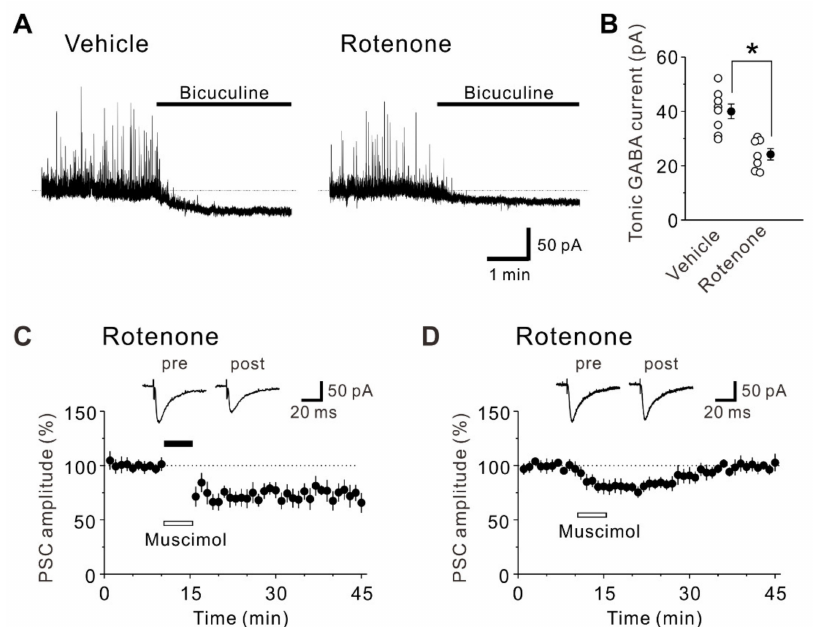
Figure 4. Reduction of tonic GABA currents caused by intranasal administration of rotenone and restoration of LTD by muscimol in pyramidal neurons of rotenone-treated mice. ( A ) Representative current traces recorded before and during application of 10 µ M bicuculline in pyramidal neurons obtained from vehicle-treated mice (left) and rotenone-treated mice (right). ( B ) Summary scatter plots of tonic GABA currents obtained from pyramidal neurons of vehicle-treated mice ( n = 8) and rotenone-treated mice ( n = 7). Unpaired t -test, *: p < 0.001. ( C ) LTD was induced by LTD-inducing stimuli in pyramidal neurons of rotenone-treated mice when 50 µ M muscimol was present ( n = 8). LTD-inducing stimuli are indicated by a solid bar. The insets show averages of ten consecutive current traces before (pre) and 25–30 min after the LTD-inducing stimuli (post). ( D ) LTD was not induced by muscimol application alone in pyramidal neurons of rotenone-treated mice ( n = 7). The insets show averages of ten consecutive current traces before (pre) and 25–30 min after muscimol application